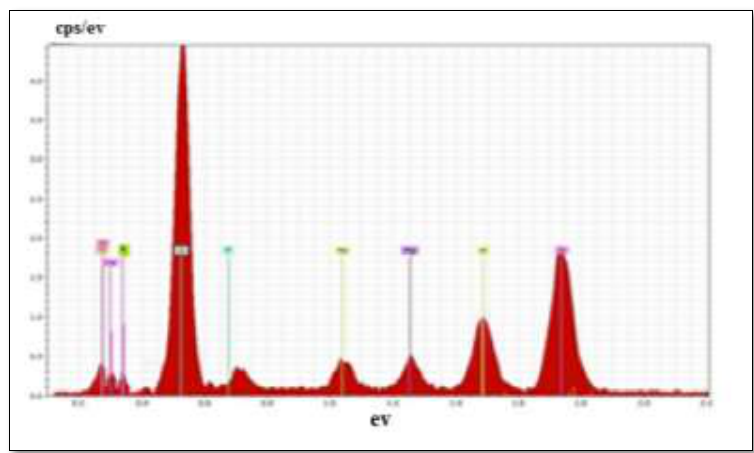
Figure 11: explain Bentonite- mortar after exposure thermal treatment.